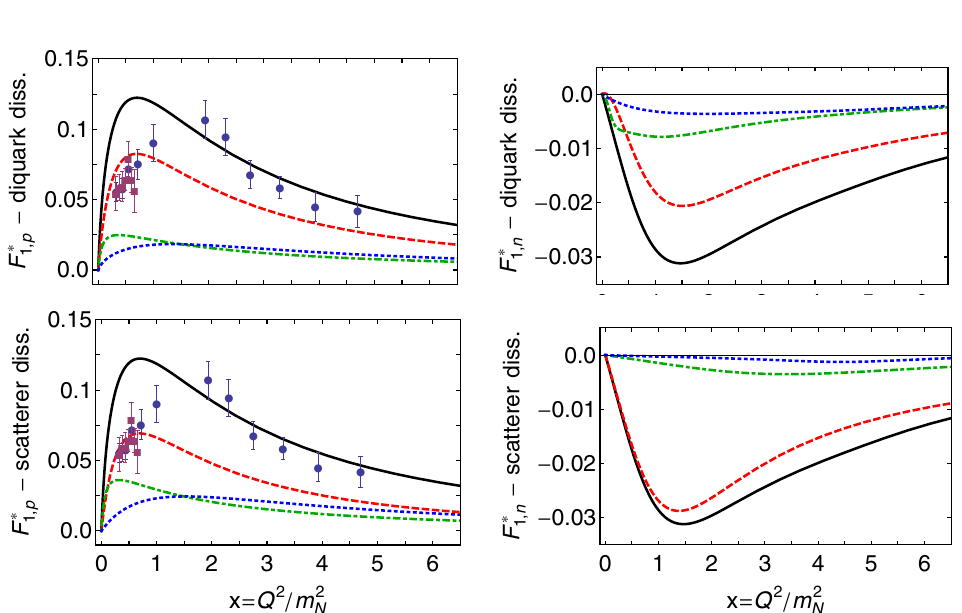
Figure 7. Computed Dirac transition form factor, F ∗ , for the charged reaction γ ∗ p → R + (left panels) and the neutral reaction 1 γ ∗ n → R 0 (right panels): solid (black) curve in each panel. Data, left panels: circles (blue) [42], and squares (purple) [43, 44]. Upper panels – diquark breakdown: DD1 (dashed red), scalar diquark in both nucleon and Roper; DD2 (dot-dashed green), pseudovector diquark in both nucleon and Roper; DD3 (dotted blue), scalar diquark in nucleon, pseudovector diquark in Roper, and vice versa. Lower panels – scatterer breakdown: DS1 (red dashed), photon strikes an uncorrelated dressed quark; DS2 (dot-dashed green), photon strikes a diquark; and DS3 (dotted blue), diquark breakup contributions, including photon striking exchanged dressed-quark.